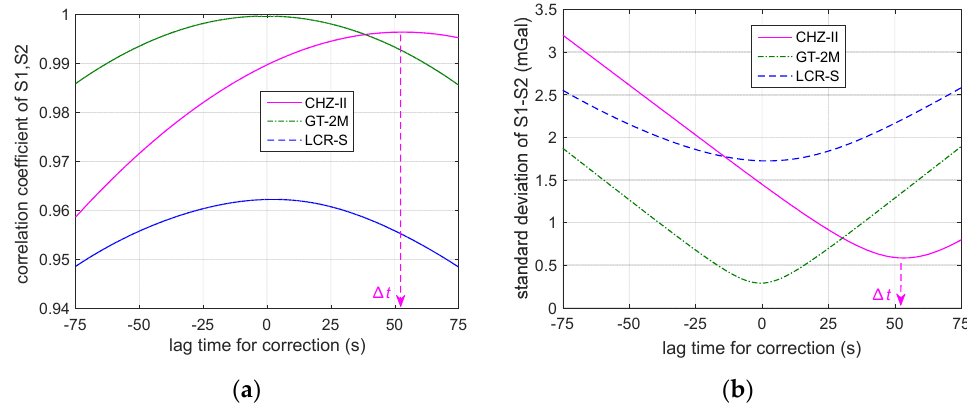
Figure 4. The influence of the damping delay time on the S1 and S2 sequence matching: ( a ) correlation coefficients; ( b ) deviation between the two measurement residuals.